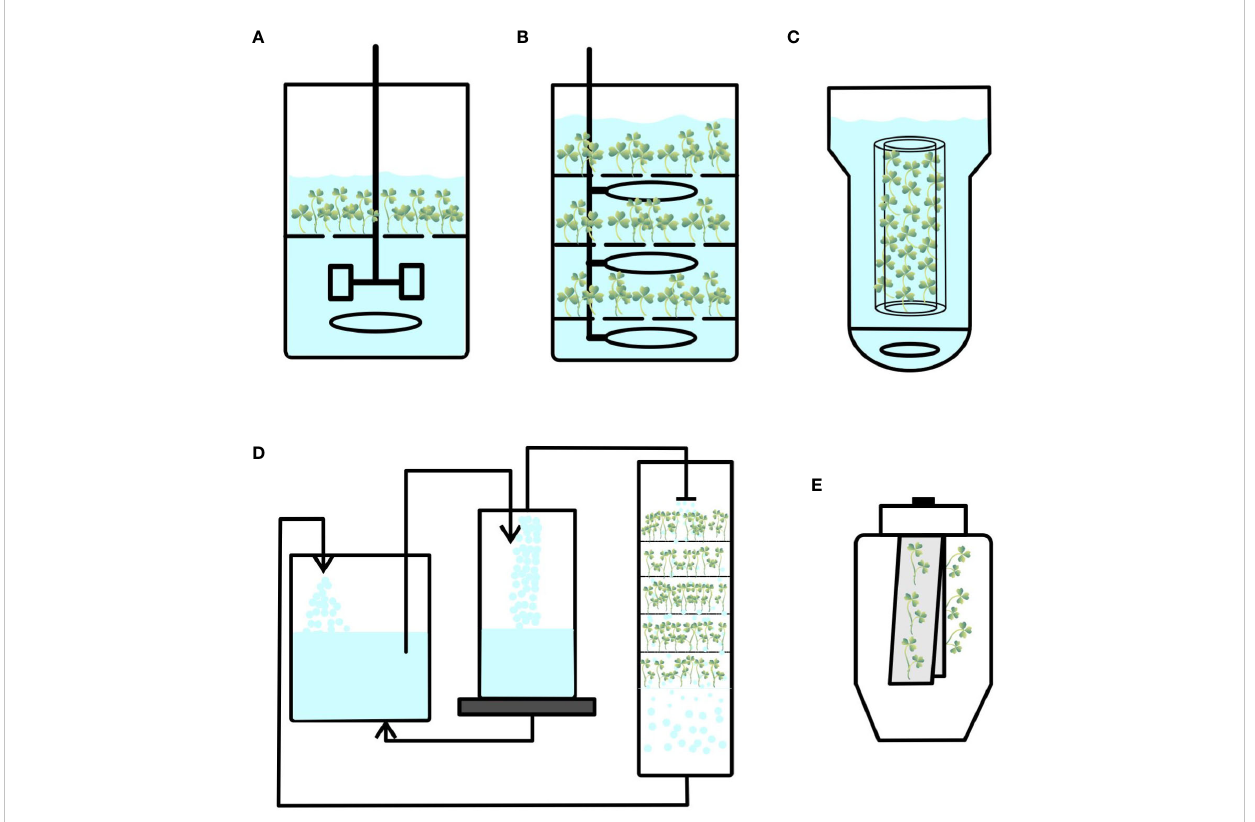
FIGURE 1 Con fi gurations of different bioreactors used for plant propagation. (A) Stirred-tank bioreactor. (B) Bubble column bioreactor. (C) Airlift bioreactor. (D) Nutrient mist bioreactor. (E) Trickle bed